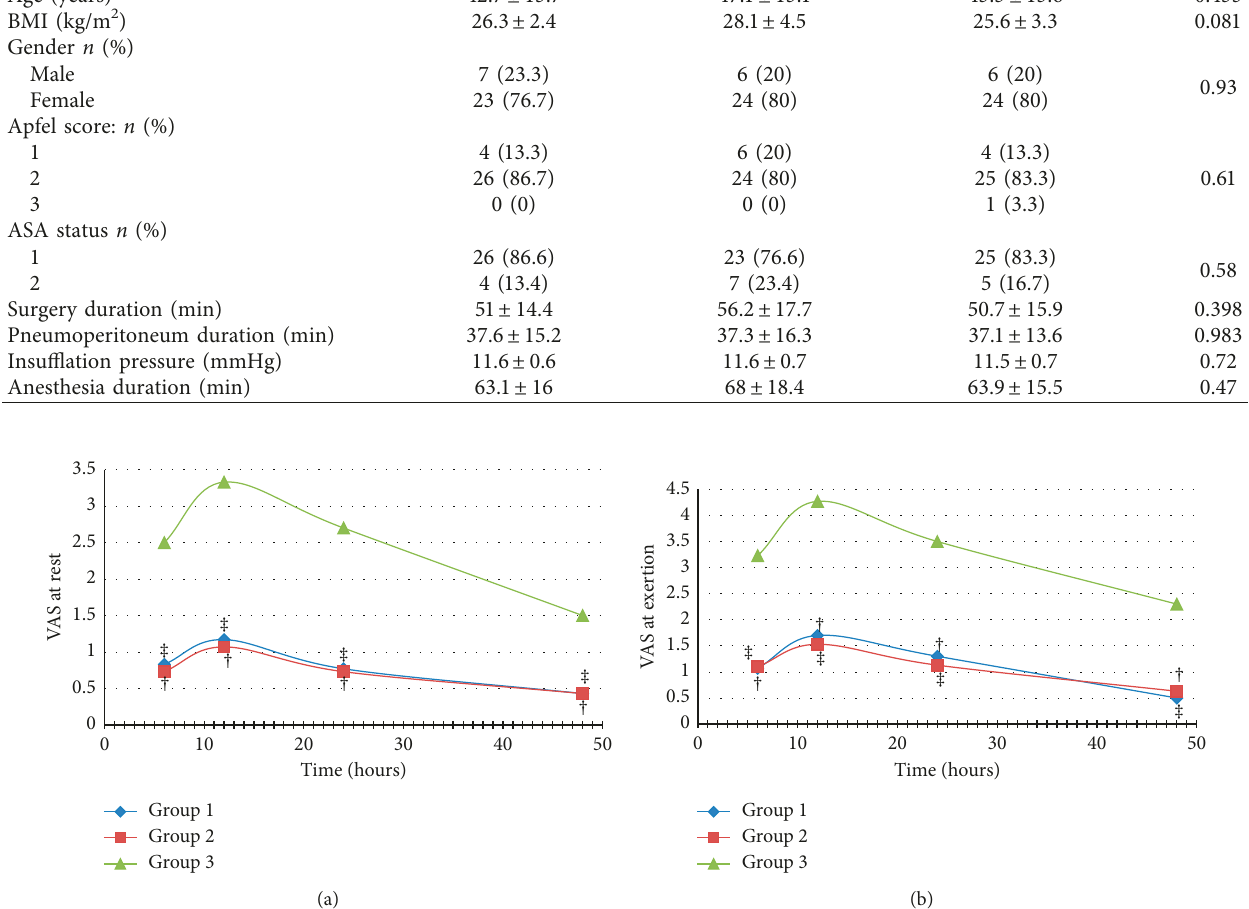
0 . 05 between groups 1 and 3. ‡ p 0 . 05 between groups < <